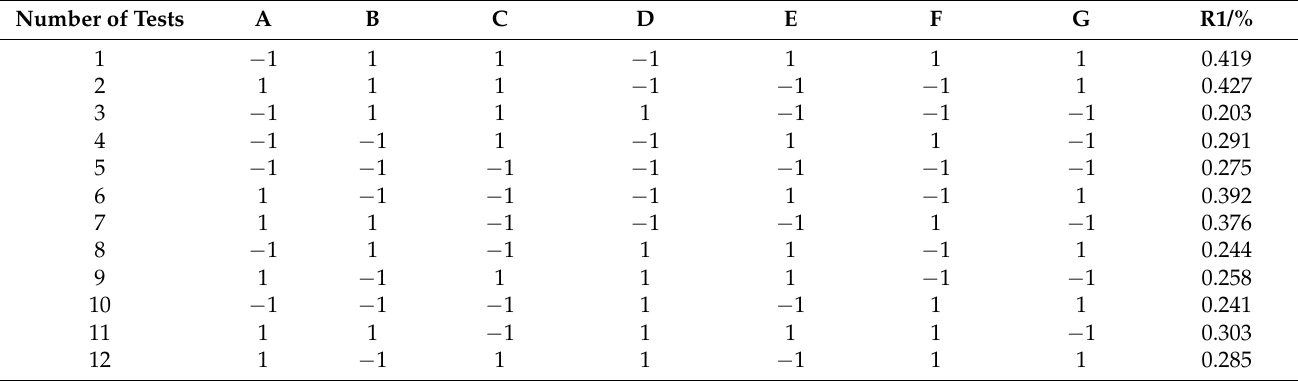
Table 4. Solid-state fermentation to produce diosgenin Plackett-Burman experimental table and